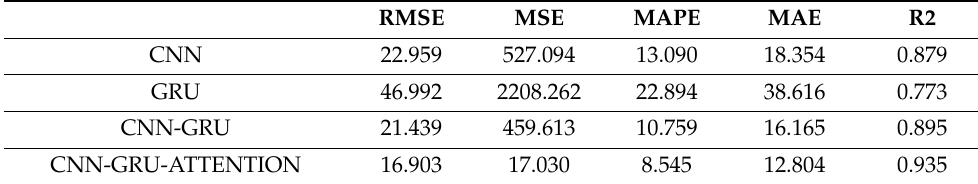
Figure 9. Residual distribution chart. Table 11. Real dataset prediction